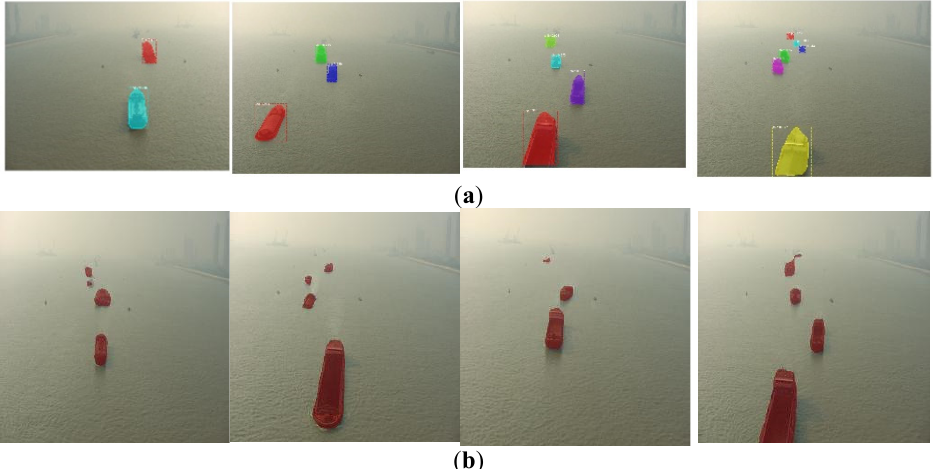
Figure 11. Samples of ship detection with Mask RCNN and FCN: ( a ) detection samples of Mask RCNN; ( b ) detection samples of FCN.